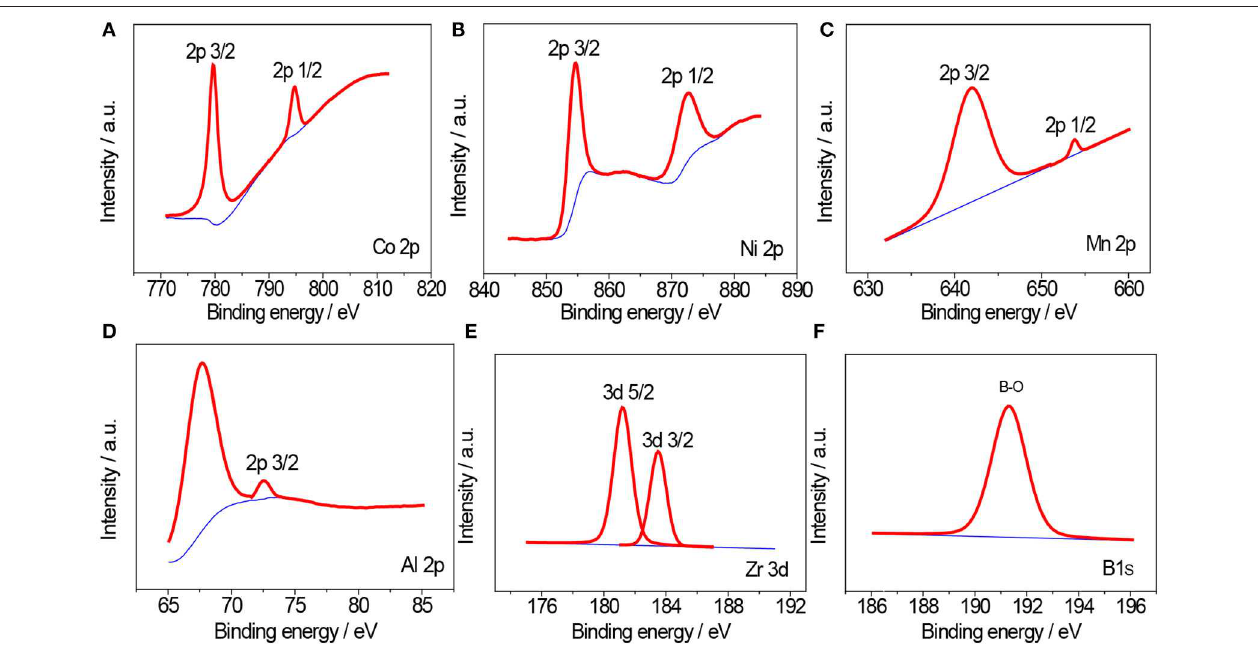
FIGURE 5 | XPS spectra of NCM811 samples ( A —Co 2p, B —Ni 2p, C —Mn 2p, D —Al 2p, E —Zr 3d, F